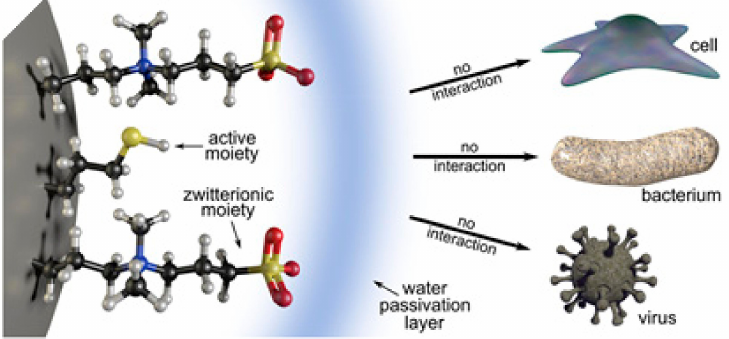
Figure 14. Schematic representation of the shielding e ff ect of the hydration layer due to the presence of zwitterionic moieties. Reprinted with permission from reference [65]. Copyright (2019)